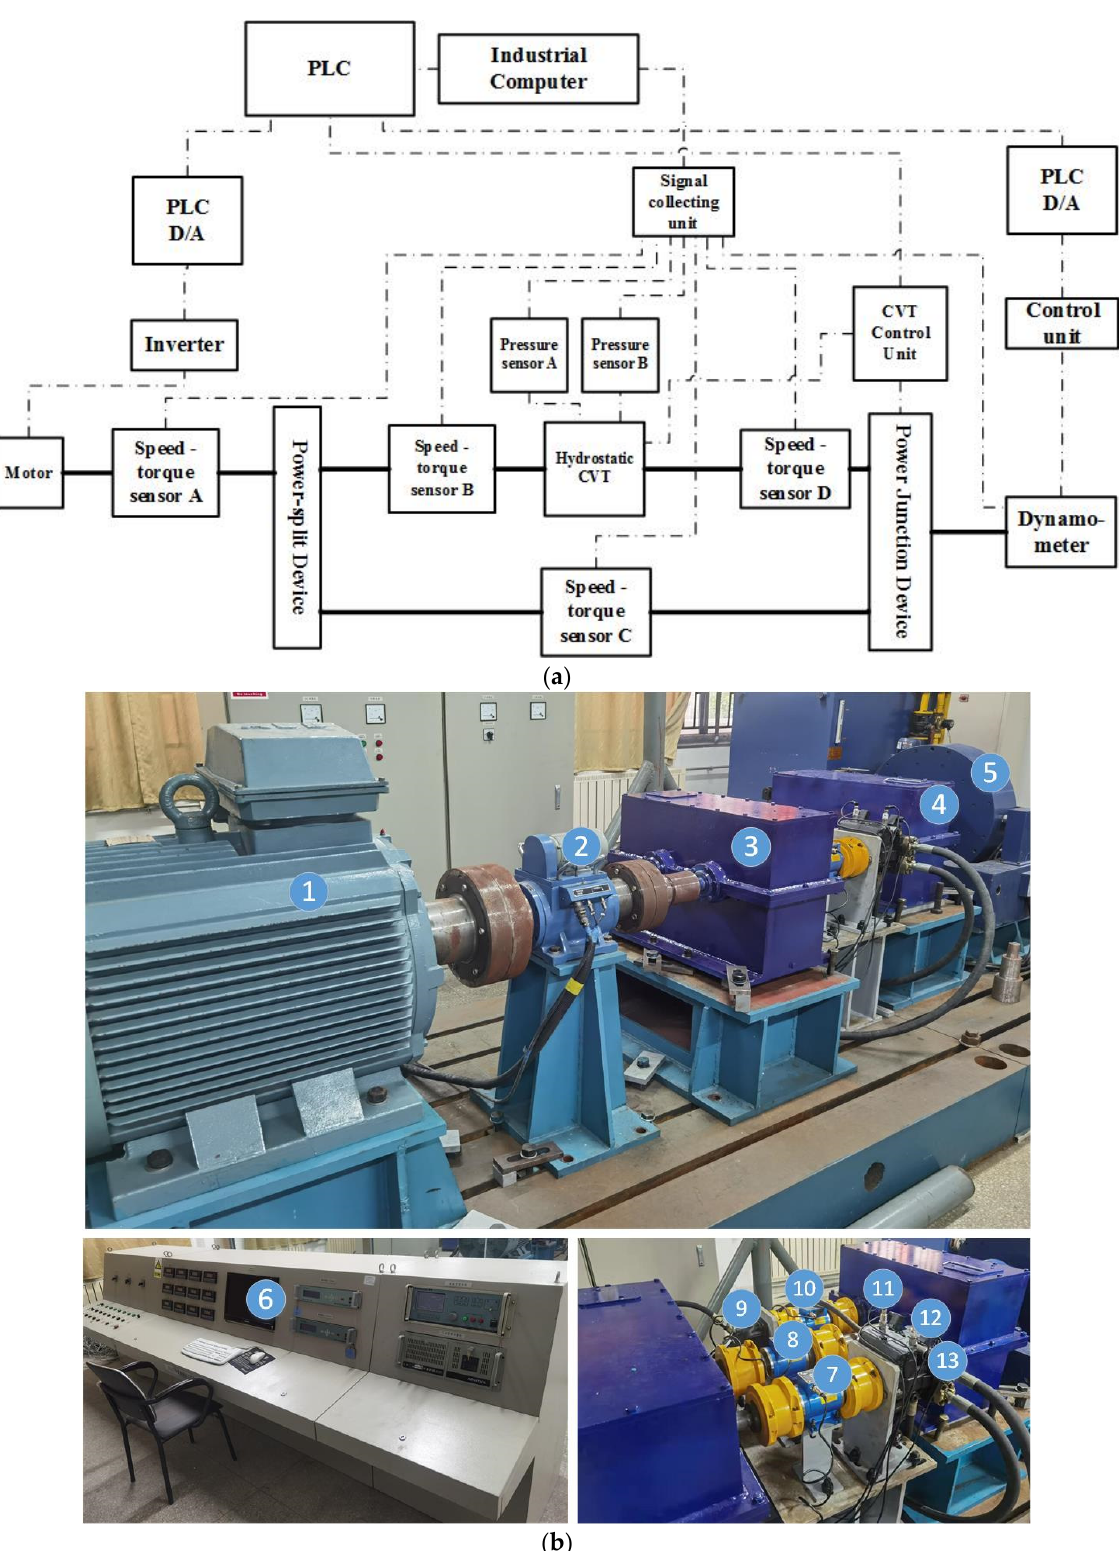
Figure 1. HMCVT multi-function test bench structure and physical diagram: ( a ) HMCVT multi-function test bench structure diagram; ( b ) HMCVT multifunctional test bench. 1 AC servo motor; 2 Speed-torque sensor A; 3 Power split device; 4 Power junction device; 5 Dynamometer; 6 Control platform; 7 Speed-torque sensor B; 8 Speed-torque sensor C; 9 Fixed displacement motor (FM); 10 Speed-torque sensor D; 11 Pressure sensor A; 12 Pressure sensor B; 13 Variable displacement pump (VP).